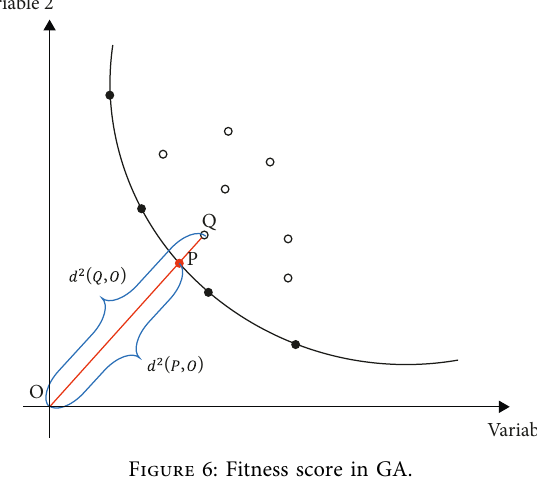
Figure 6: Fitness score in